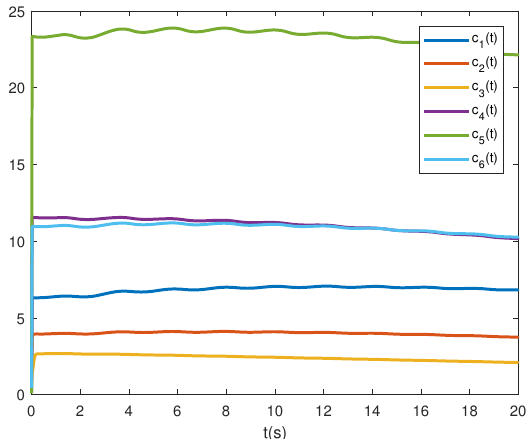
Figure 5. Consensus protocol coupling gains c i ( t ) under G 1 .